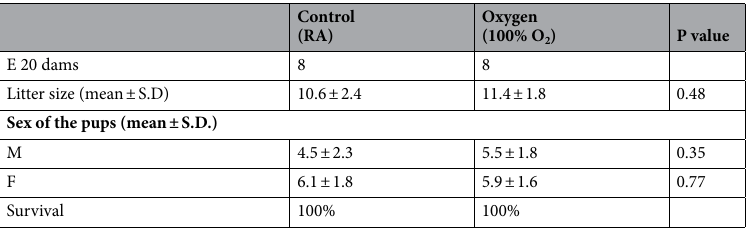
Table 1. Details of animal use. One male and female pup/unique dam/treatment condition was used for experiments unless stated otherwise, with the dam as the experimental unit. M: male offspring; F: female offspring.